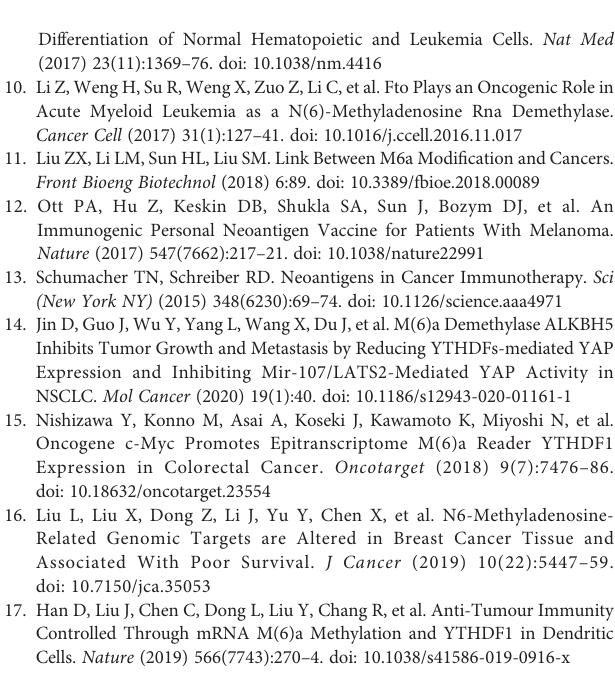
Supplementary Figure 5 | Correlation between YTHDF1 expression and 24 tumor in fi ltrating lymphocytes (TILs) in KICH analyzed by the GEPIA database. Supplementary Figure 6 | Correlation between YTHDF1 expression and 24 tumor in fi ltrating lymphocytes (TILs) in PRAD analyzed by the GEPIA database. Supplementary Figure 7 | Correlation between YTHDF1 expression and 24 tumor in fi ltrating lymphocytes (TILs) in KIRC analyzed by the GEPIA database. Supplementary Figure 8 | Correlation between YTHDF1 expression and 24 tumor in fi ltrating lymphocytes (TILs) in KIRP analyzed by the GEPIA database. Supplementary Figure 9 | Correlation between YTHDF1 expression and 24 tumor in fi ltrating lymphocytes (TILs) in BLCA analyzed by the GEPIA database. Supplementary Figure 10 | Correlation between YTHDF1 expression and 24 tumor in fi ltrating lymphocytes (TILs) in TGCT analyzed by the GEPIA database. Supplementary Figure 11 | YTHDF1 differential expression in fi ve urogenital cancers with different clinical subgroups analyzed by the UALCAN database. Supplementary Table 1 | Sample Numbers of the TCGA Cancer types and corresponding immune and molecular subtypes. Supplementary Table 2 | Correlation between YTHDF1 expression and survival in the GEO datasets analyzed by the PrognoScan database. Supplementary Table 3 | Detailed relationship between YTHDF1 expression and pan-cancer immune cell in fi ltration in the tumor microenvironment. Supplementary Table 4 | Relationship between YTHDF1 expression and relatedimmune marker setsof urogenital cancersanalyzed by theTIMER database. Supplementary Table 5 | 24 tumors associated in fi ltrating lymphocytes (TILs) and their gene markers. Supplementary Table 6 | YTHDF1 coexpression genes in urogenital cancers analyzed by the LinkedOmics